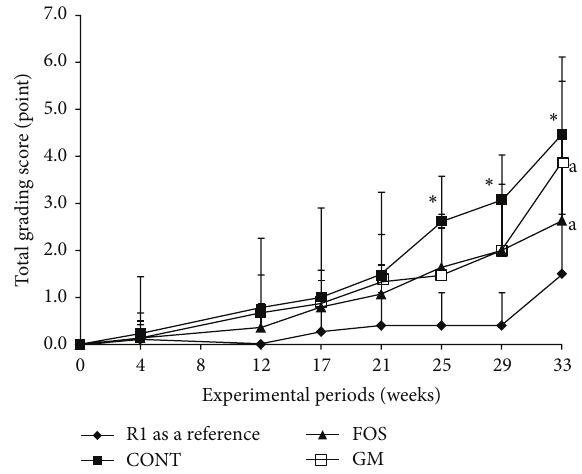
Figure 1: Effects of FOS or GM feeding on grading score of SAMR8 during feeding period. Values were expressed as mean ± SD. R1, SAMR, 𝑛 = 10 ; CONT, control diet, 𝑛 = 15 ; FOS, 5% of fructooligosaccharide diet, 𝑛 = 15 ; GM, 5% of glucomannan diet, 𝑛 = 15 . ∗ Significant differences were evaluated versus CONT by one-way ANOVA and Tukey’s post hoc test, at 𝑃 < 0.05 . a: significant difference between FOS and GM by one-way ANOVA and Tukey’s post hoc test, at 𝑃 < 0.05 .